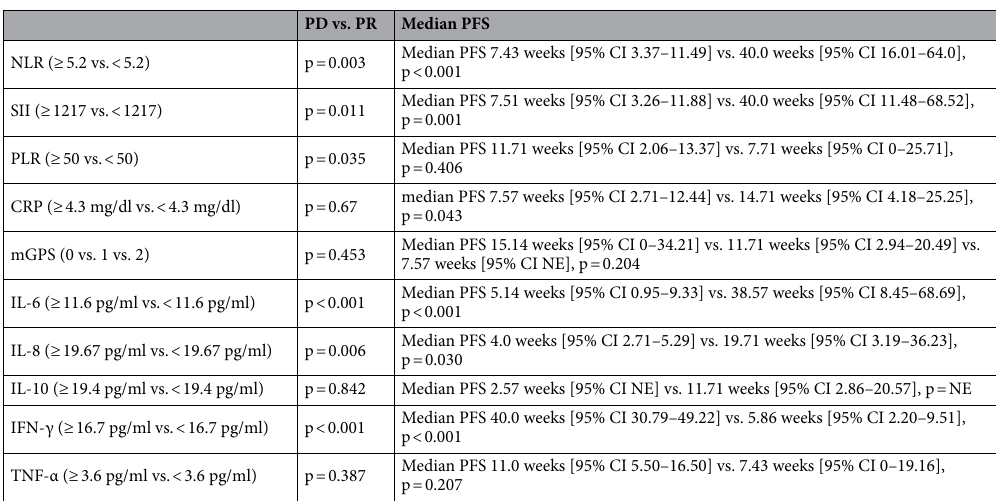
PD vs. PR Median PFS